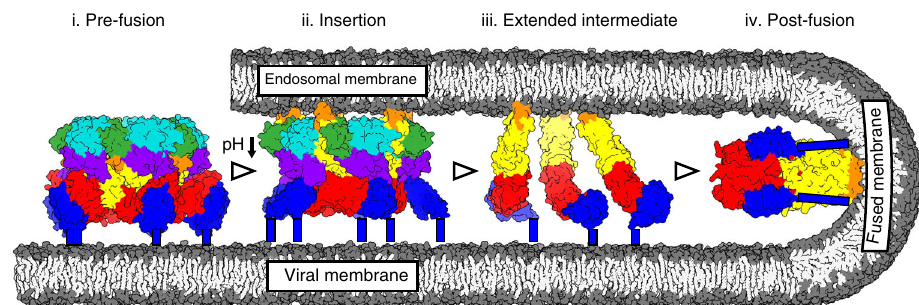
Fig. 4 Model for phlebovirus Gc-mediated membrane fusion. (i) In the pre-fusion state at neutral pH the Gc fusion loops (orange) are buried in the structure. (ii) At the fusion permissive pH below 5.0 (downward arrow) 9 and upon exposure to a target membrane, the Gn moves to the side of the Gc, fully exposing the fusion loops at the tip of the Gc domain II. Consequently, full extension of Gc leads to the insertion of the fusion loops in the target membrane. (iii) The Gn – Gc dimers dissociate, allowing extended Gc monomers to redistribute on the viral membrane. (iv) After the merging of the endosomal and viral membranes, Gc adopts a trimeric post-fusion conformation (modelled in SWISS-MODEL 62 using a phleboviral Gc post-fusion trimer PDB:5G47 as a template) where fusion loops are embedded in the fused membrane. Gn and Gc domains are coloured as in Fig. 2 and membrane is coloured in grey, with lipid head groups in darker and acyl chains in lighter shade. C-terminal part of Gc domain III that links the protein to the viral membrane is missing in the crystal structures and is indicated with blue